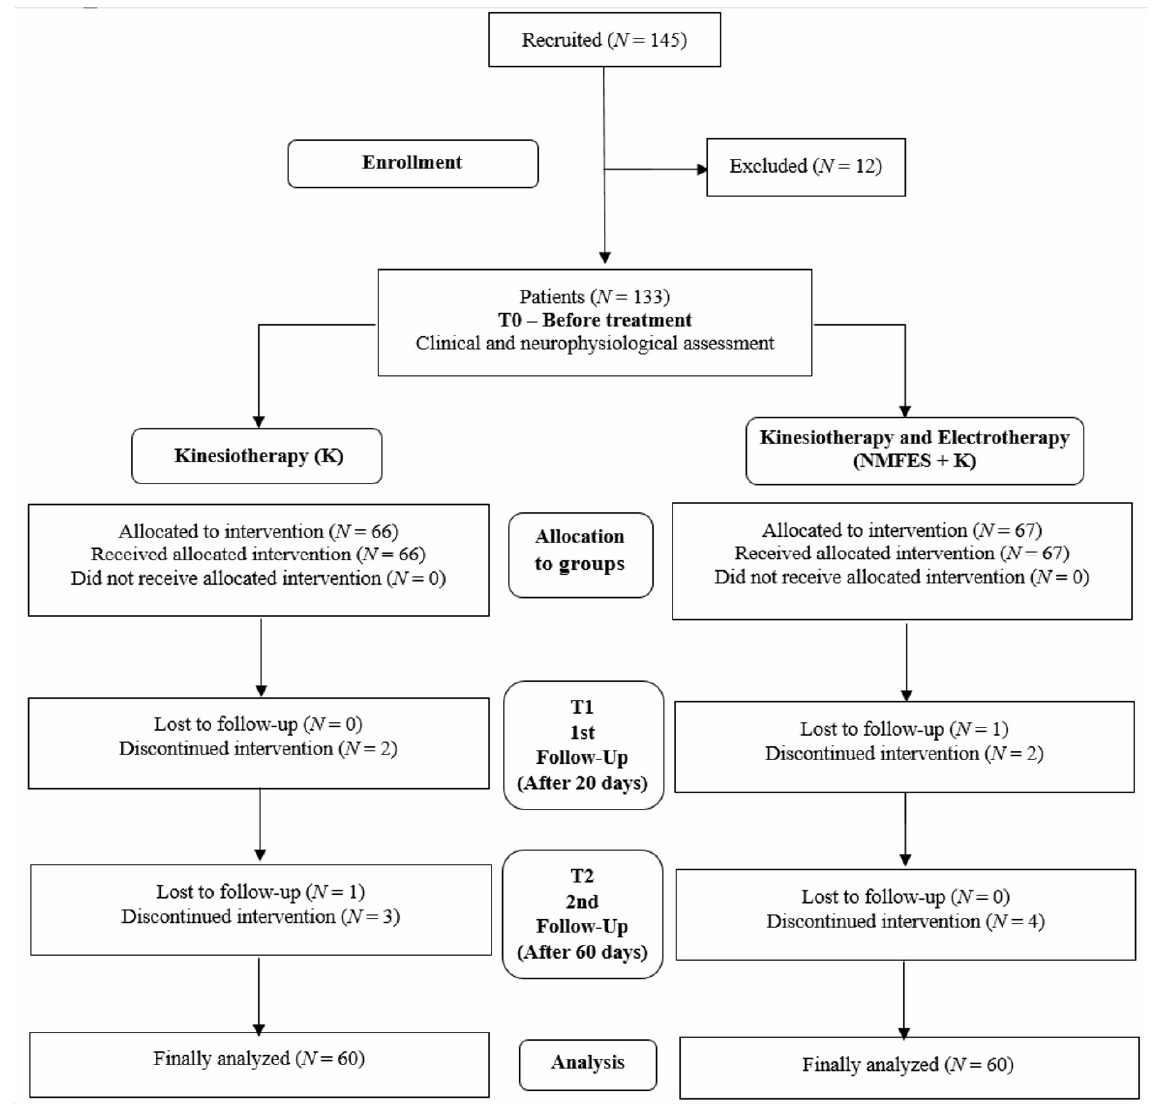
Figure 1. Flow chart of the study. Table 1. Characteristics of the subjects.